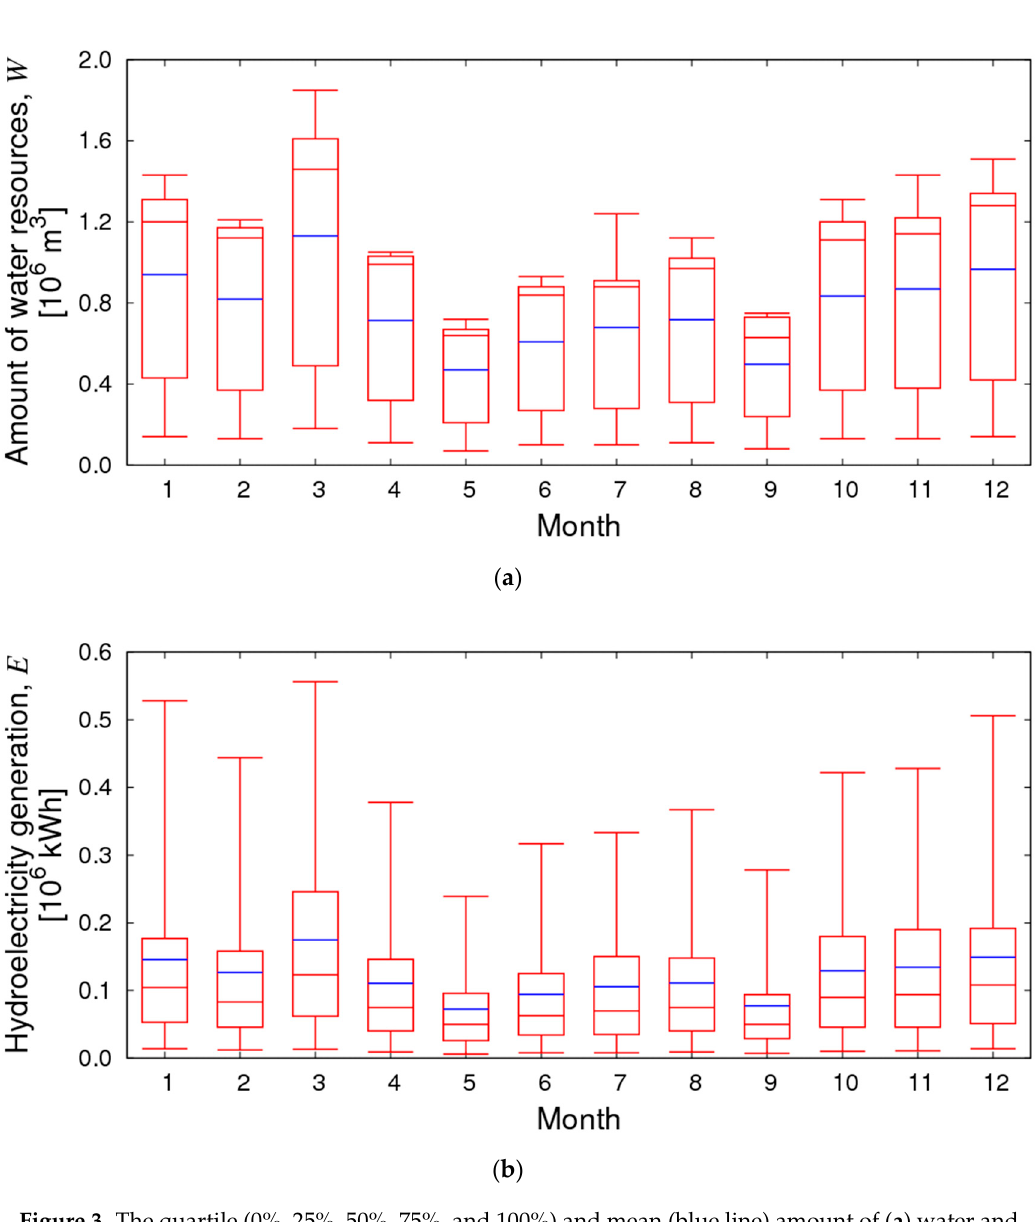
Figure 3. The quartile (0%, 25%, 50%, 75%, and 100%) and mean (blue line) amount of ( a ) water and ( b ) hydroelectricity from each dam through precipitation enhancement.